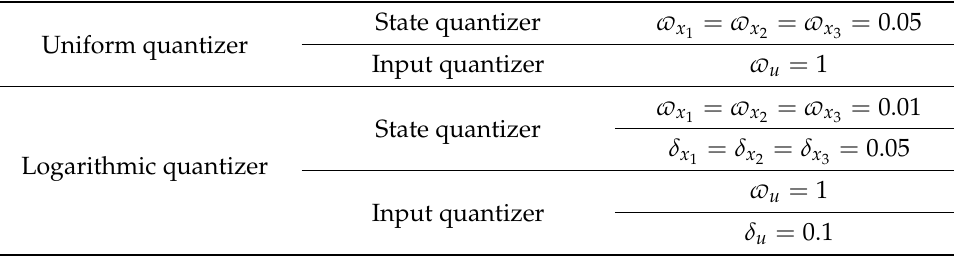
Table 3. The parameter settings of the quantizers.